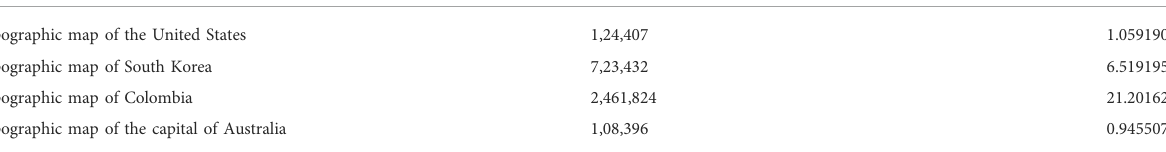
TABLE 7 Time analysis of SMCLM-3ME.